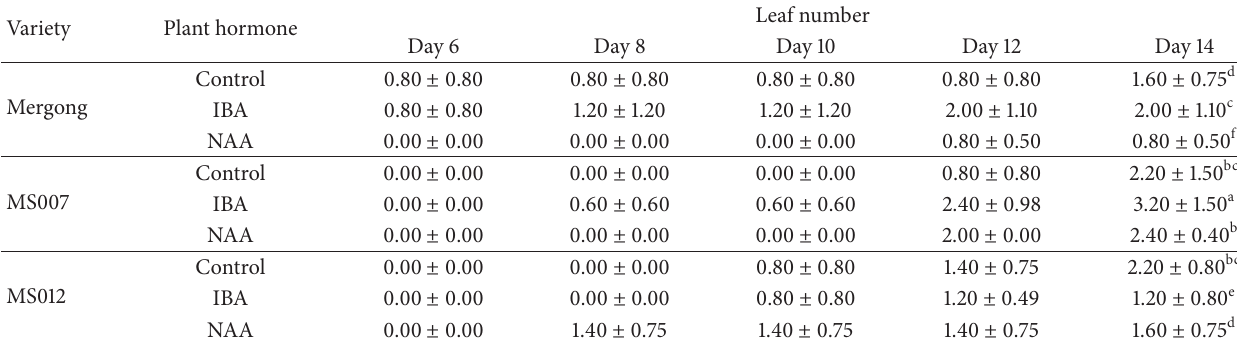
Table 7: Mean leaf number of three varieties treated with IBA and NAA from day 6 to day